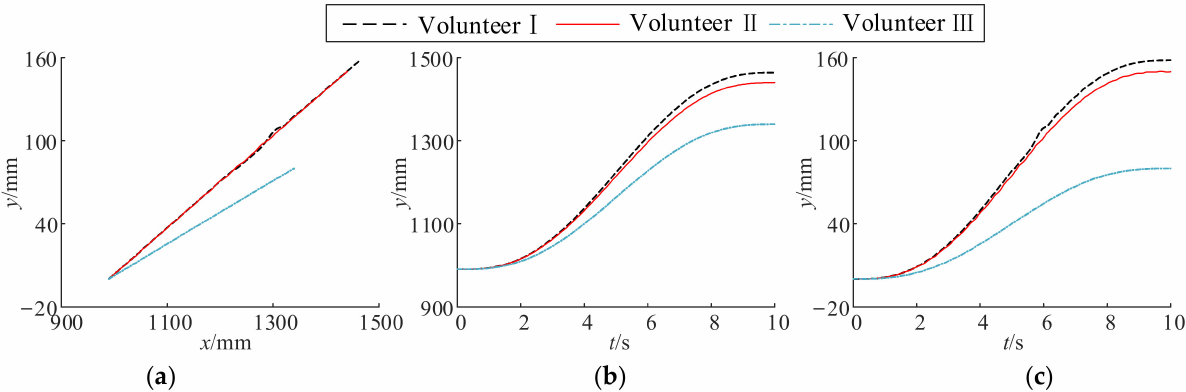
Figure 14. Terminal trajectories and y-value variation with time. ( a ) The end of the track. ( b ) The terminal x value varies with time. ( c ) The terminal y value varies with time.